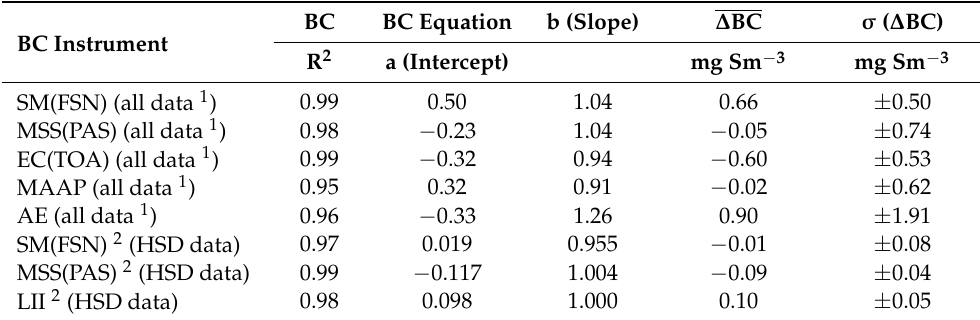
Table 2. Statistical analysis of the BC results obtained with different methods. BC BC BC Instrument